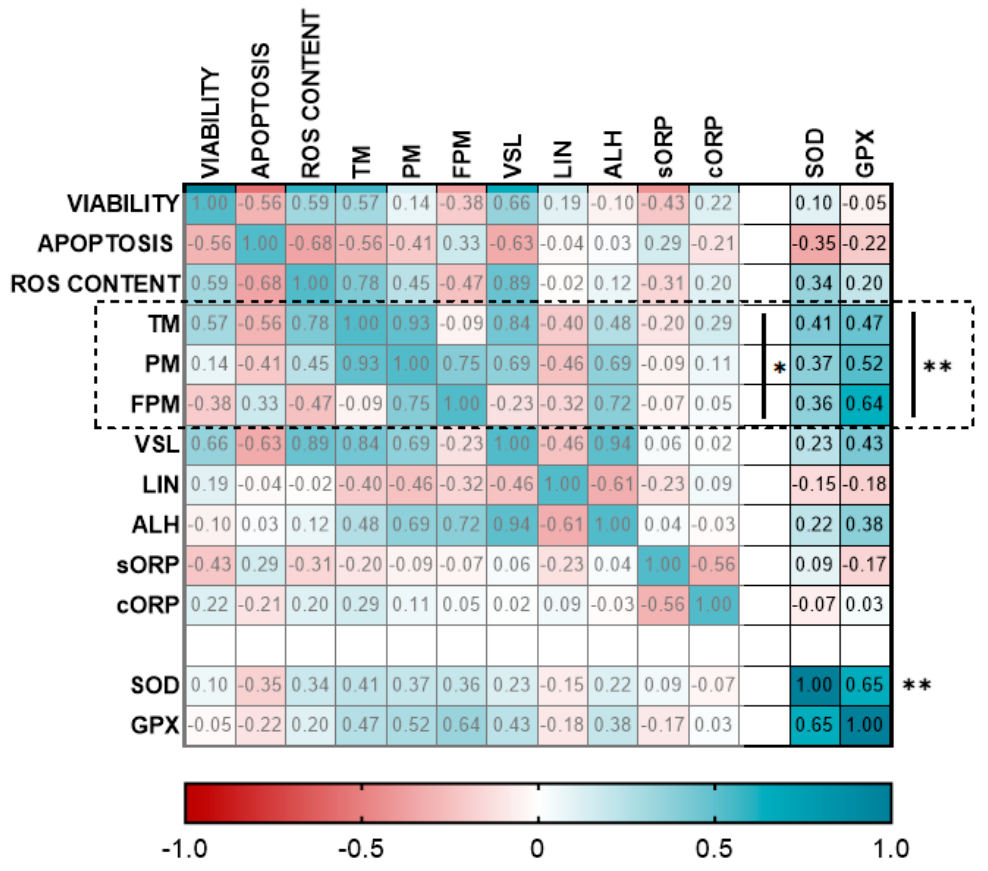
Figure 5. Correlation matrix of all sperm quality markers evaluated, highlighting the correlations of SOD and GPX activities. The three experimental groups: without sperm collection (0 CW), 4 sperm collections per week (4 CW), 10 sperm collections per week (10 CW) were included to calculate the correlation matrix. The R squared value between two parameters is represented in each cell. Blue indicates positive correlations and red indicates negative correlations. The color intensity represents the strength of the correlation between two sperm quality parameters. A total of ten males were analyzed (the same number of samples is required in this analysis). Asterisks show significant correlations among sperm quality parameters. The number of asterisk (*) indicates the significance levels: (*) indicates p < 0.05 and two asterisks (**) indicates p < 0.01.